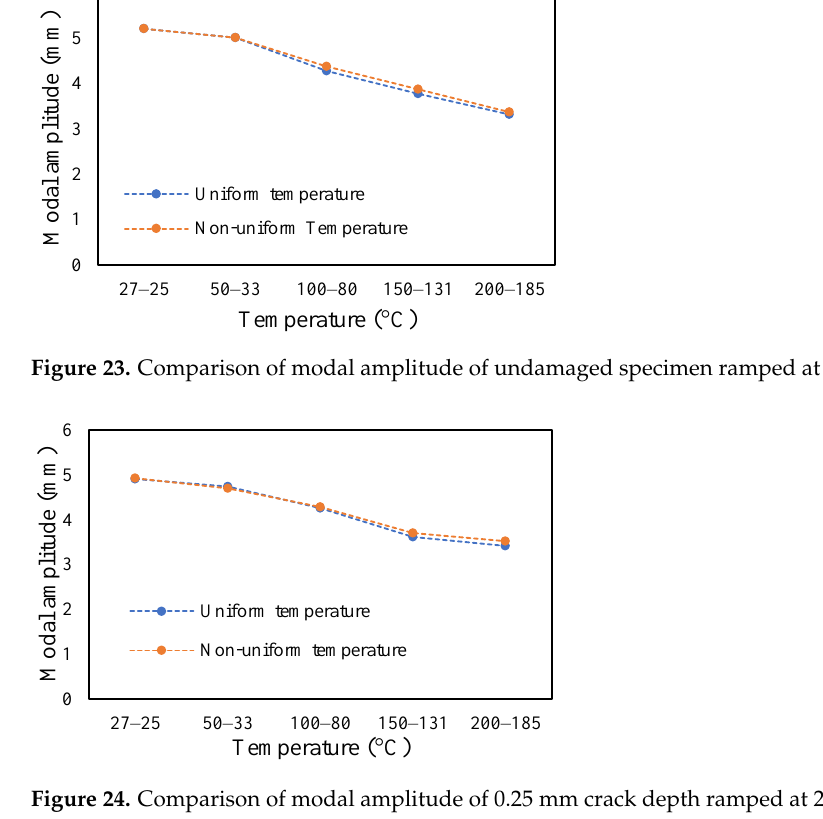
14 of 24 Figure 19. Comparison of natural frequency of undamage specimen ramped at 2 °C/min. Figure 20. Comparison of natural frequency of 0.25 mm crack depth ramped at 2 °C/min.